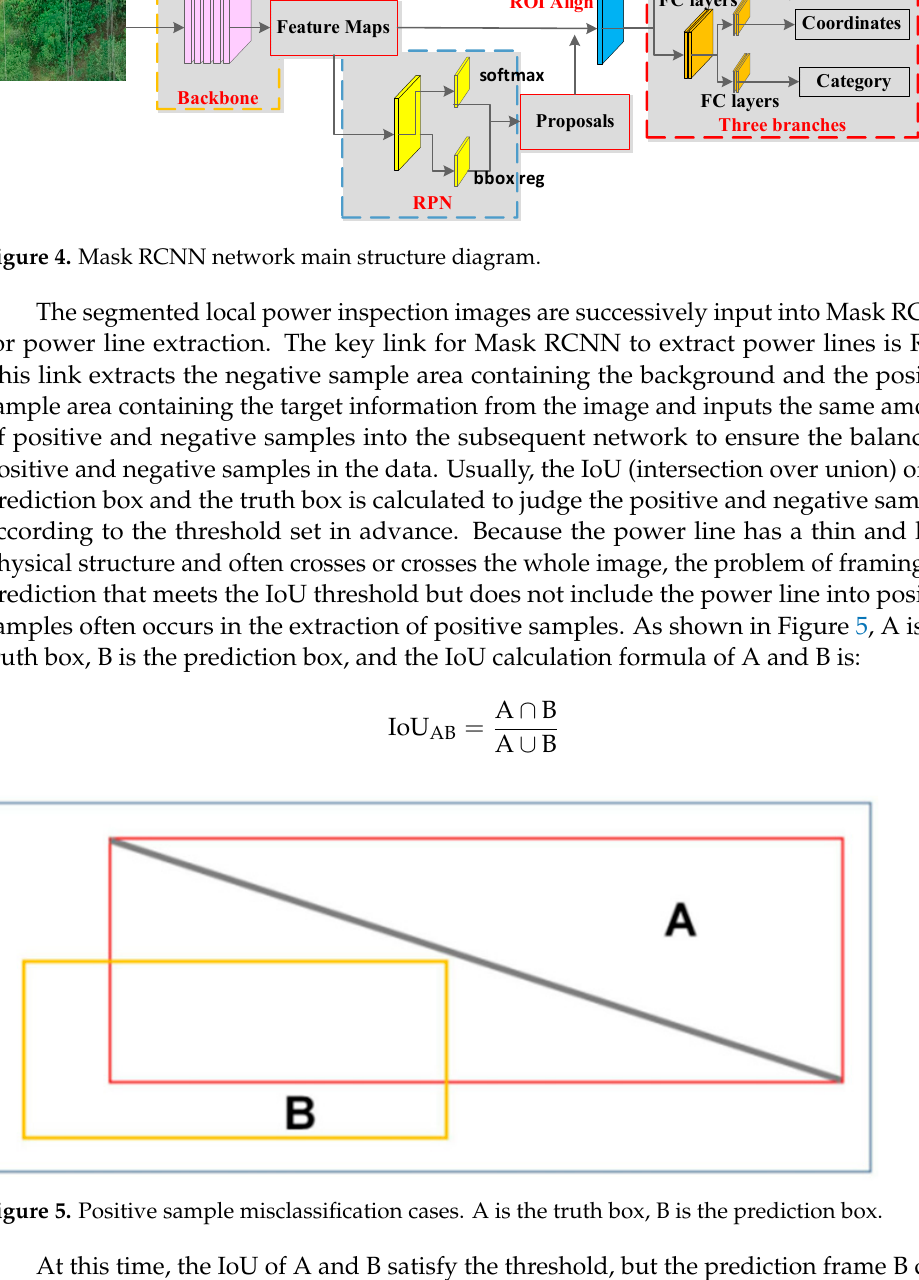
Figure 4. Mask RCNN network main structure diagram.